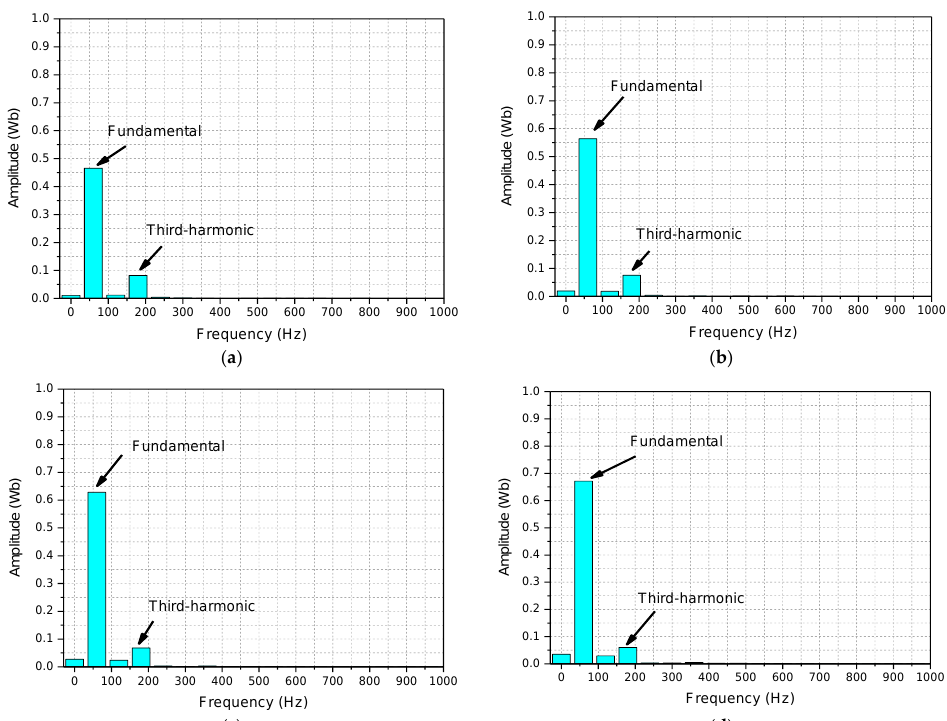
Figure 6. Flux linkages of the machine having ( a ) 0.6 A, ( b ) 1.2 A, ( c ) 1.8 A, and ( d ) 2.4 A dc offset for each phase of armature currents.